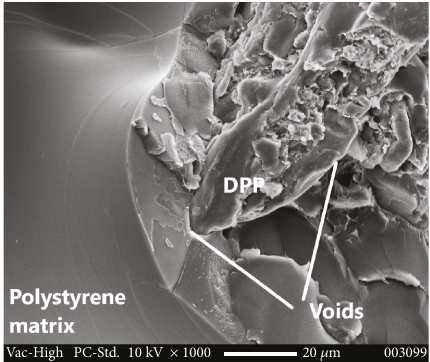
Figure 4: Filler agglomeration in 50-DPP